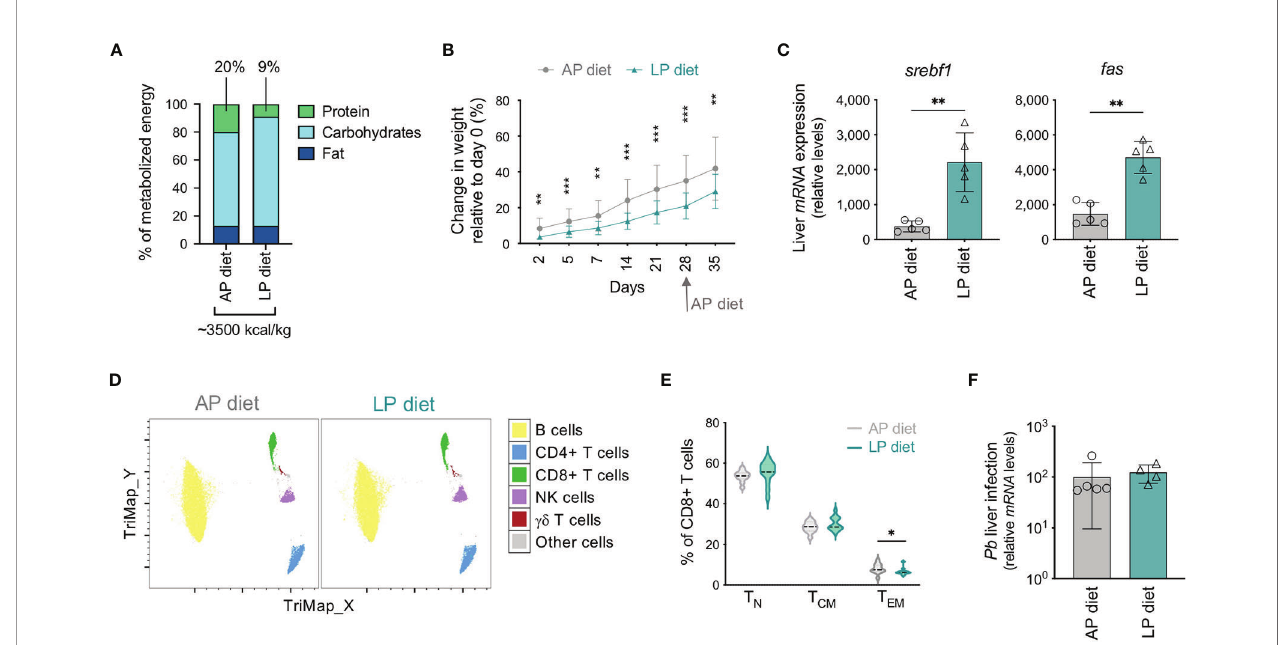
FIGURE 1 | Optimization of a protocol of low protein diet that impacts the host but does not in fl uence parasite development. (A) Composition of the adequate (AP, 20%) or low (LP, 9%) protein diets used in the study. (B) Change in weight (relative to day 0) of mice under AP or LP diet. Data were from 16-18 mice of 3 independent experiments. (C) Hepatic expression of srebf1 and fas on day 35 in mice maintained under each protocol. Values were normalized to hprt expression. Each symbol represents one mouse. (D) TriMap dimensionality reduction analysis of circulating immune populations in concatenated data of mice maintained under AP or LP diets on day 28, based on the following markers: CD3, CD4, CD8, CD19, CD25, TCR gd and NK1.1. (E) Violin plots of the frequency of naïve (T N ), central memory (T CM ) and effector/effector memory (T EM ) populations within CD8+ T cells in mice maintained under AP or LP diet, on day 28 (n = 11-13 per group). (F) Pb liver load at 48h post-infection (10,000 infectious Pb sporozoites) of mice maintained under each protocol and infected on day 35. Levels of hepatic Pb 18S rRNA were normalized to hprt expression. Data are presented as mean ± SD and were compared using the Mann-Whitney test (*P < 0,05; **P < 0,01; ***P <